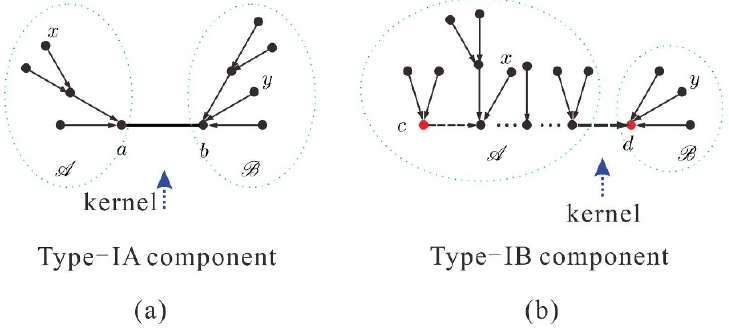
Figure 15 . Graph (a) is a type-IA component, while graph (b) is a type-IB component. The kernel of (a) is de(cid:12)ned by the type-1 line between nodes a and b . The kernel of (b) is de(cid:12)ned by the type-4 line which is connected to the (un(cid:12)xed) end node d . The nodes x and y in each graph are supposed to be the highest-weight nodes in the regions A and B , respectively. If the weight of x is higher than that of y , A and B are correspondingly the top and the bottom sides. Contrarily, if the weight of y is higher than that of x , A becomes the bottom side while B the top. Here, K [ U (cid:8) L nG 0 ] is the product of all k (cid:1) k factors corresponding to the given